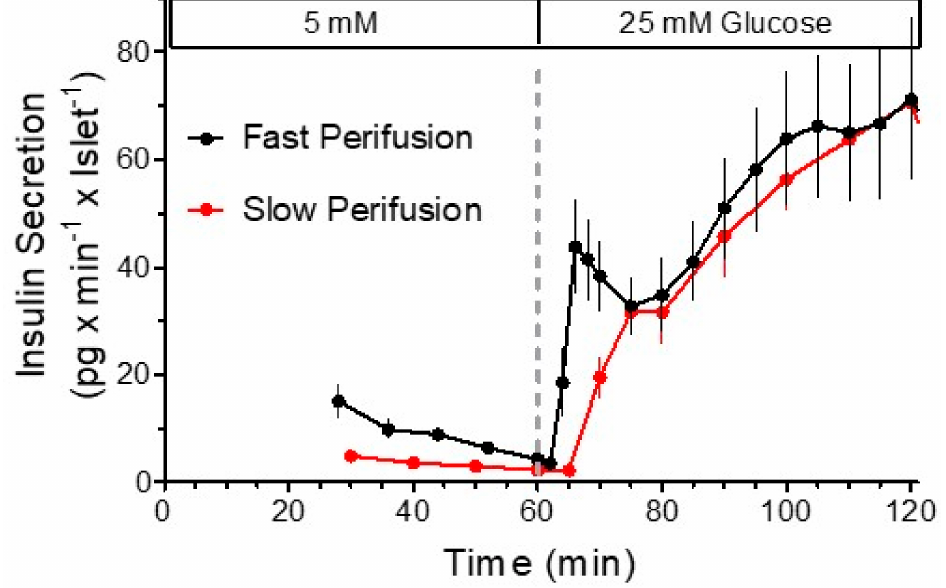
Figure 2. The kinetics of nutrient-induced insulin secretion are strongly dependent on the velocity of nutrient increase. The only difference between the experimental conditions of the secretory responses shown in this figure is the pump rate of the perifusion and, by consequence, the steepness of the glucose gradient. The final concentration was reached after 5 min or 35 min,